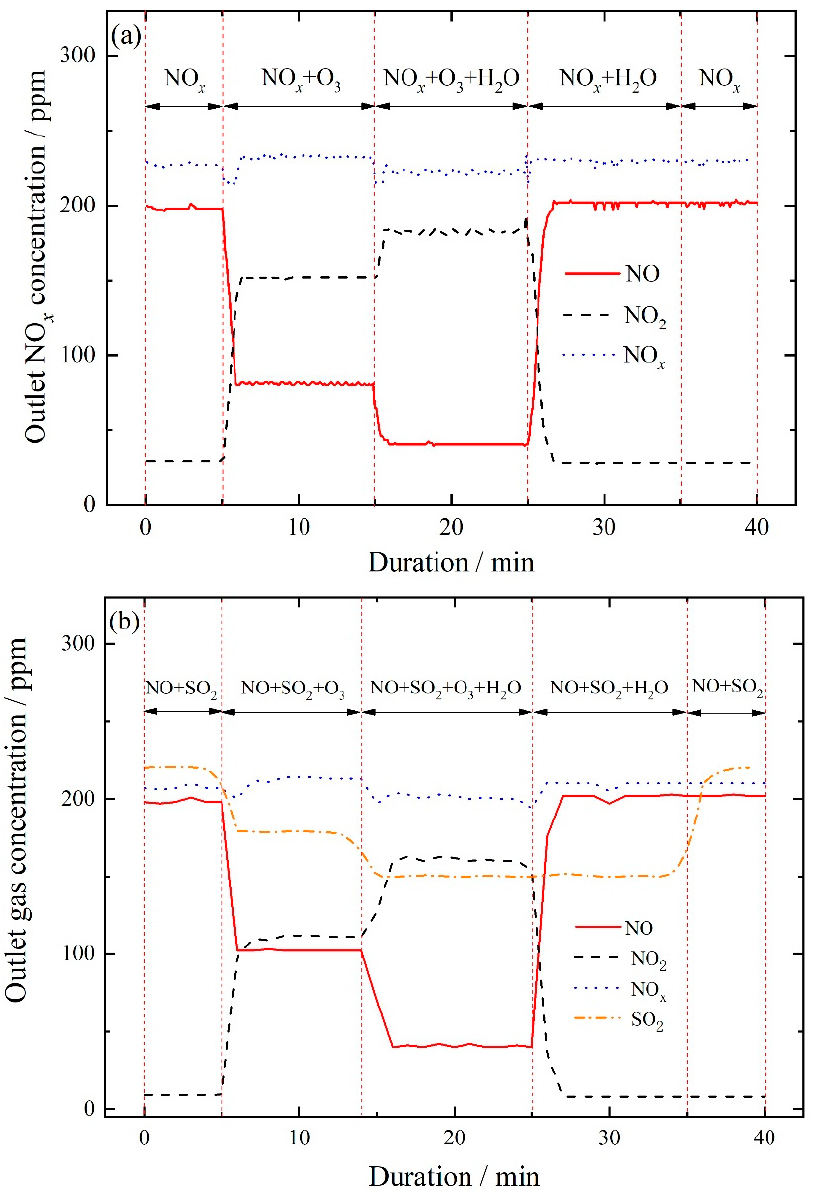
Figure 7. Changes of outlet gas concentrations with reaction duration at the absence ( a ) and presence ( b ) of SO 2 in inlet flue gas.